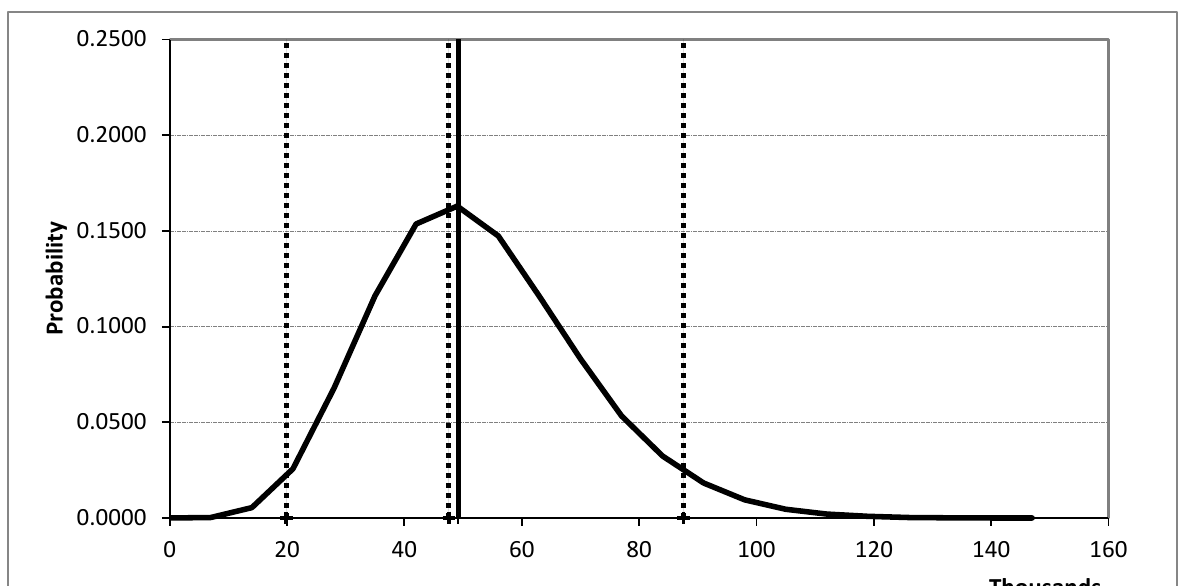
Figure 3. Additional quit estimate